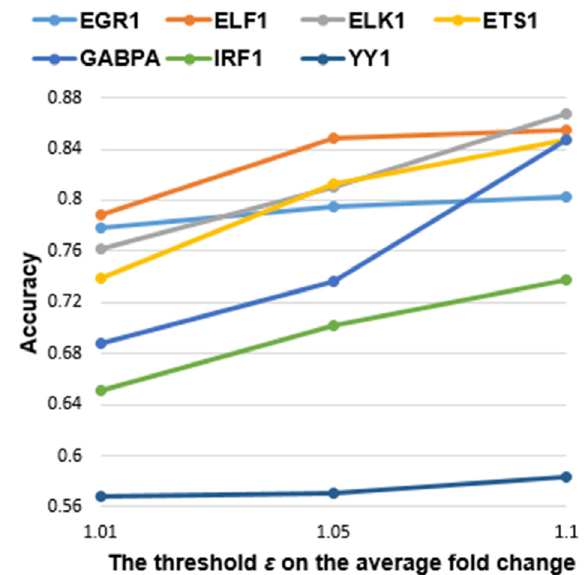
Figure 4. Accuracy of the Decision Tree classifier when using three different values for. Each accuracy value was averaged from 10 rounds of 10-fold cross validation. The minimum threshold ε of the average fold change in gene expression levels (for all guide RNAs) of the TF was determined for fold changes: 1.01, 1.05 and 1.1. The accuracy value of each individual round is indicated in Additional file 5 22 . As ε increased, accuracy for all seven TFs monotonically increased.